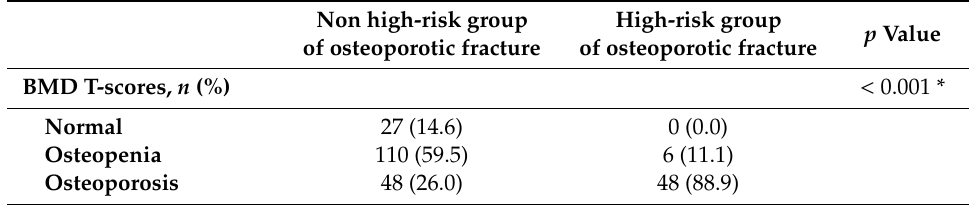
Table 8. Distributions of the BMD categories between the two groups based on the FRAX calculations without femur BMD T-scores in the patients with knee